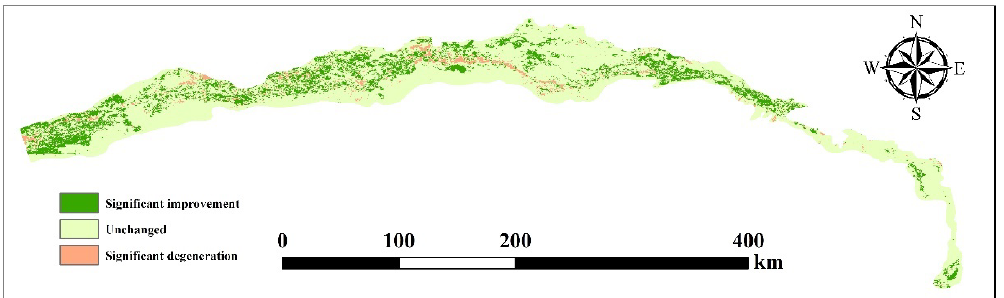
Figure 9. Spatial variation distribution of vegetation coverage in the mainstream area of the Tarim River from 2015 to 2021.